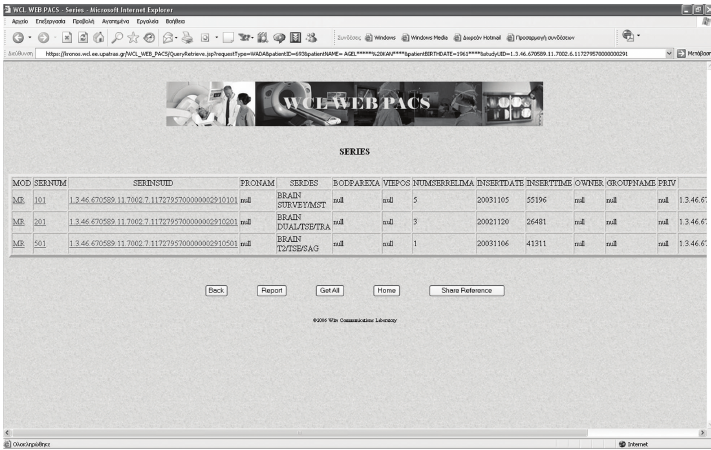
Figure 4: User interface of the WADA service—Series table of a Study.